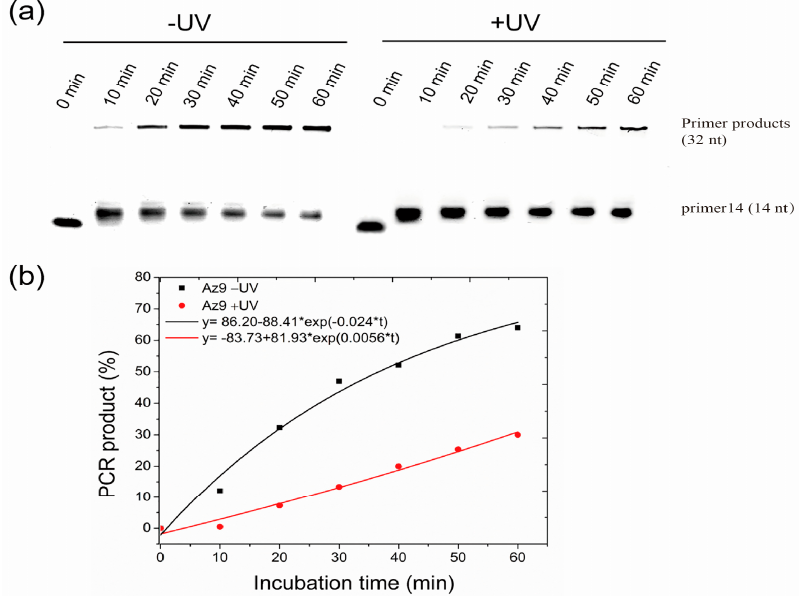
Figure 6. ( a ) Denaturing PAGE (20%) of photomodulaton of the primer extension by Taq polymer- ase in the presence of 1 μ M FAM-primer and Tem32 template, 1 μ M azobenzene-linked asODNs (Az9) and 1 U enzyme in 20 μ L Taq buffer without ( − ) or with (+) UV irradiation at 37 °C with increasing incubation time. Aliquots of each incubated sample were removed at 0, 10, 20, 30, 40, 50 and 60 min. ( b ) Kinetics analysis for photoregulation of primer extension using Az9 in 20 μ L Taq buffer containing 1 U enzyme at 37 °C with increasing incubation time. PCR Product (%) refers to the percentage of full-length product of the primer extension reactions.